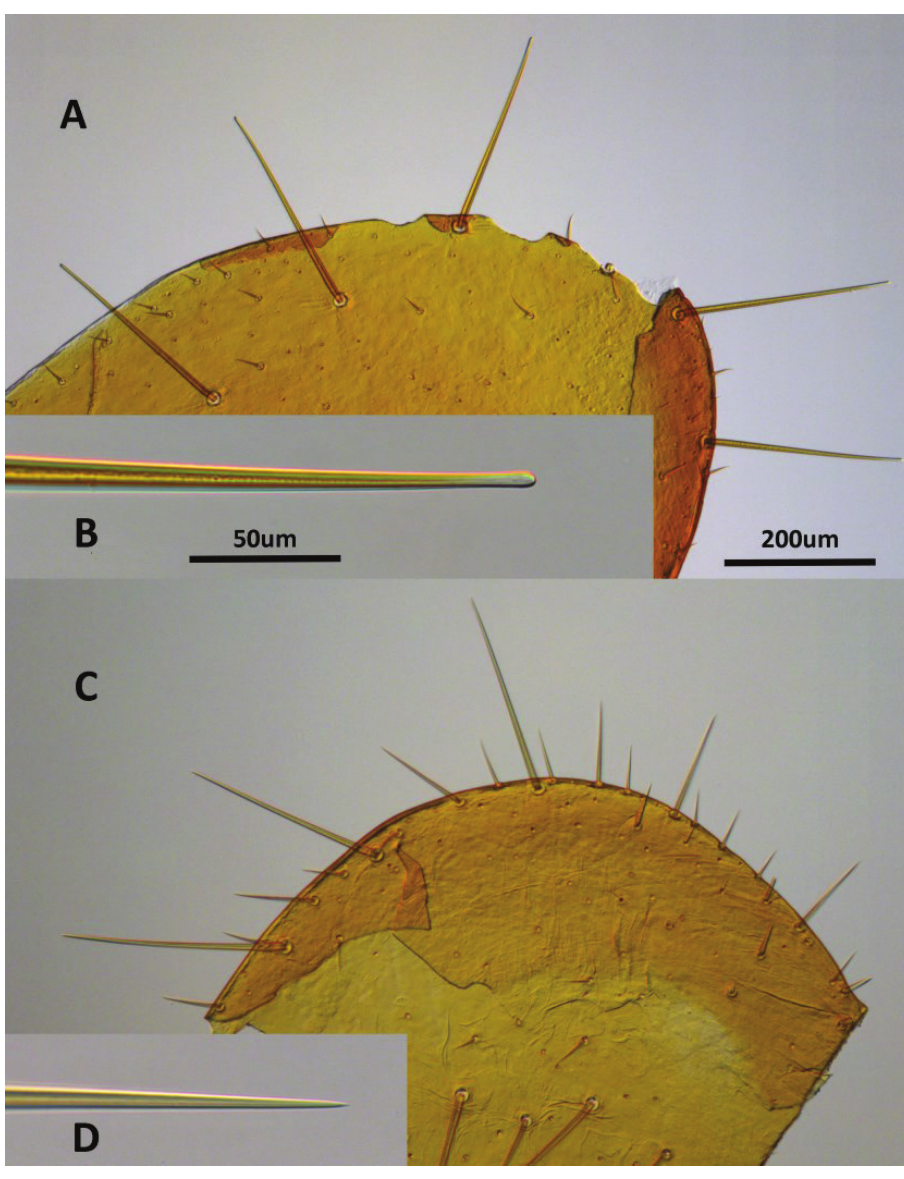
Figure 2. Neotermes setae on pronotum cuticle. Neotermes aburiensis ( A, B ) and N. castaneus (Bur- meister) ( C, D